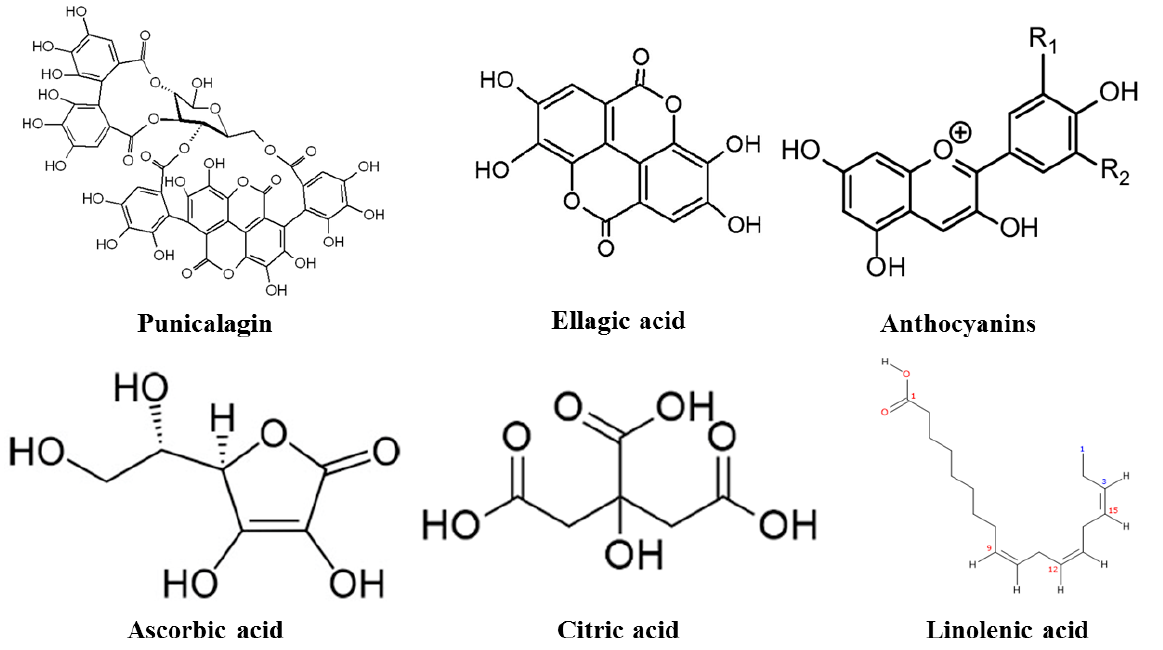
Figure 2. Pomegranate’s constituents chemical structure.